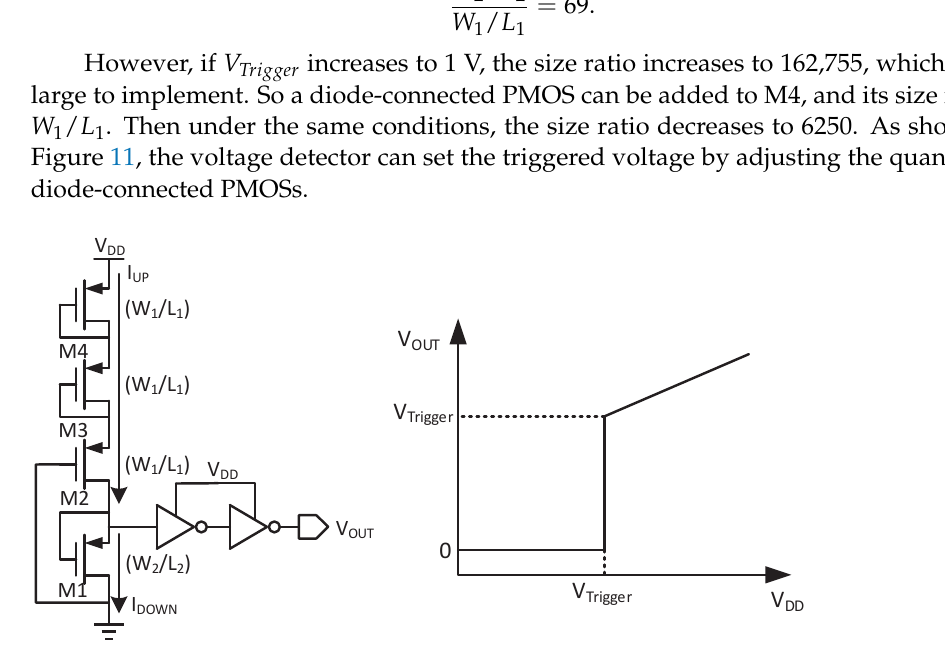
Figure 11. Schematic of the voltage detector and its